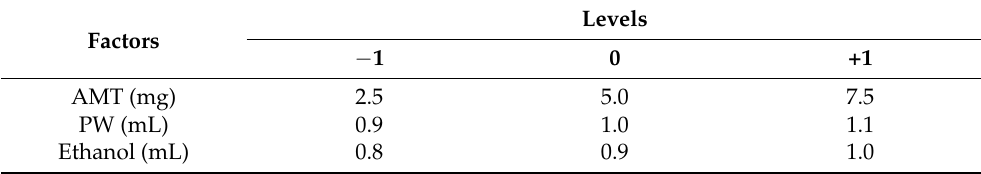
Table 3. Experimental design of AMT-loaded BSA nanoparticles. Independent variables selected for optimization of AMT-loaded BSA nanoparticles, and the investigated values in the 3-level ( − 1, 0 and +1), 9-run full factorial